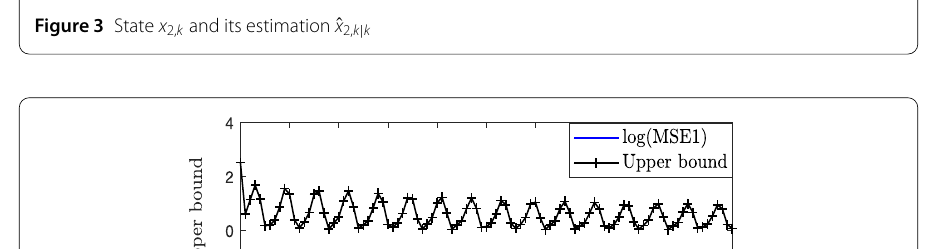
= 0.5 and χ (1) = 0.01. Other 0